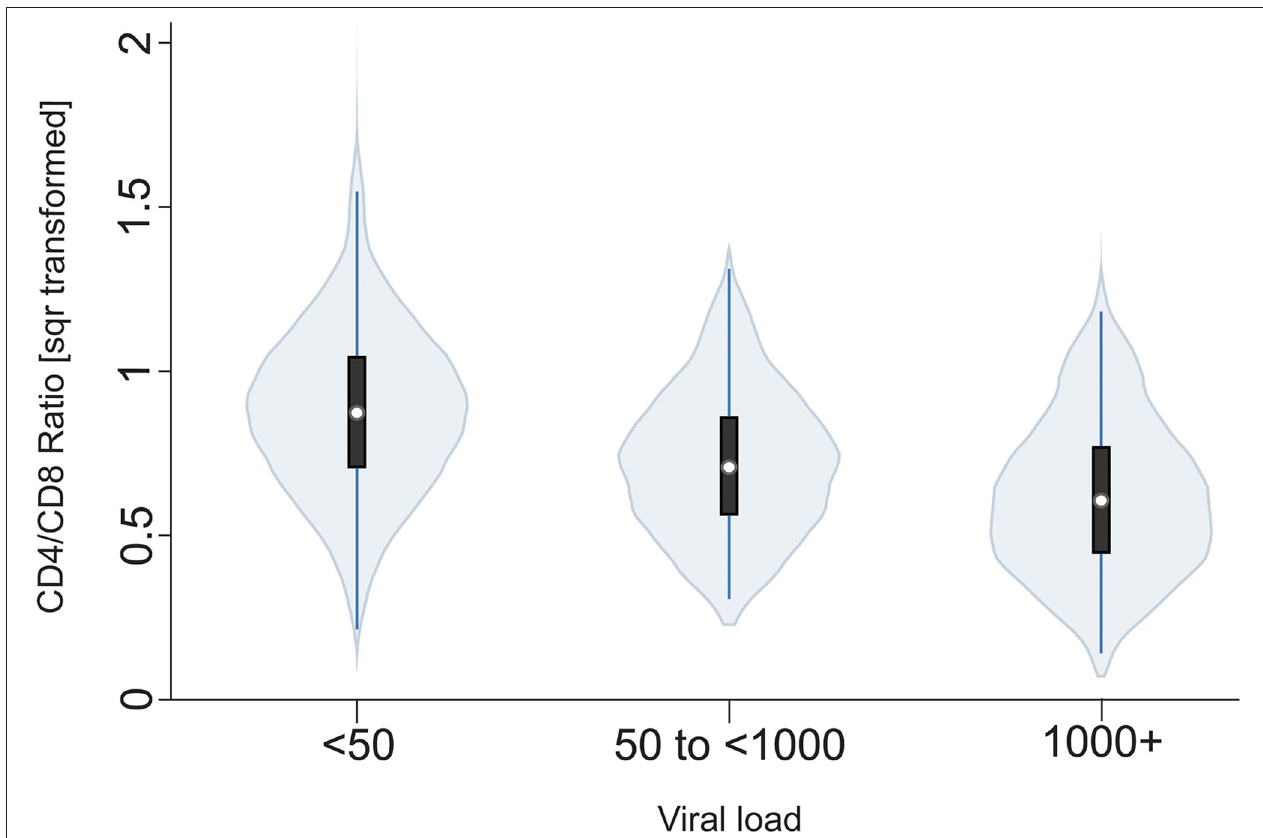
FIGURE 1 | Violin plot of the relationship between CD4/CD8 ratio and viral load. Square root transformed CD4/CD8 ratios are shown on the y-axis which decrease as a function of increasing viral loads ( < 50 copies, 50–1,000 copies and > 1,000 copies) shown on x-axis [ b = − 0.13 (se 0.01), p < 0.001].